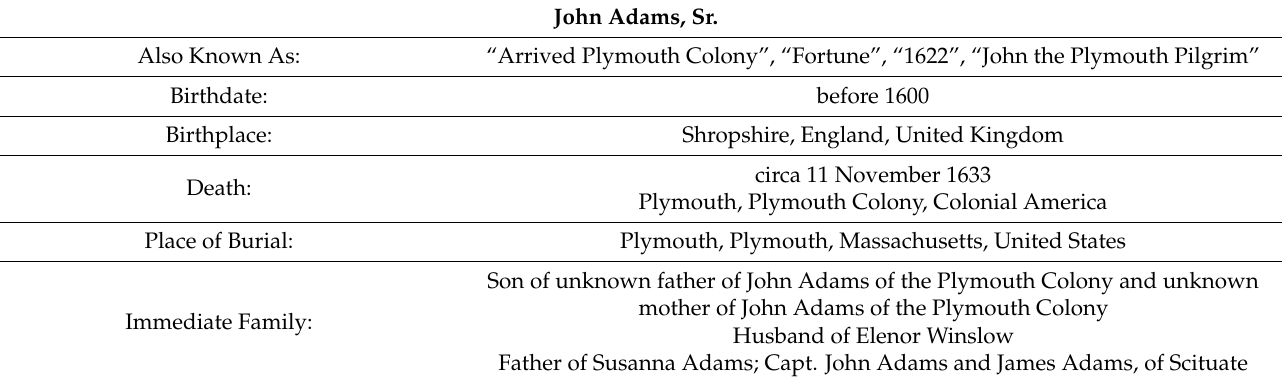
Table 1. Biographical details of second Adams